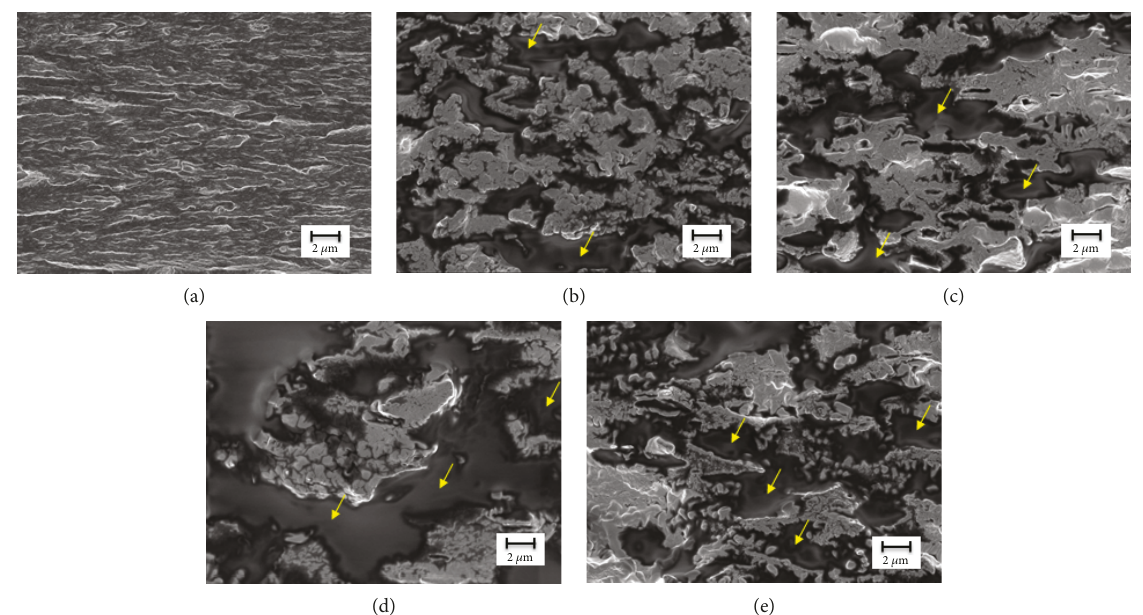
Figure 3: Scanning electron microscopy (SEM) images of the fracture surface of alginate fi lms incorporating various CEO-NE concentrations viewed at a magni fi cation of 5000x: (a) control, (b) CEO-NE 20%, (c) CEO-NE 25%, (d) CEO-NE 30%, and (e) CEO-NE 40%. Arrows show cavity-like structures in the fi lm matrix. Table 2: Optical properties ( L , a , b , and Δ E ) and moisture content of the control and CEO-NE-alginate fi lms. Di ff erent letters in the same column indicate signi fi cant di ff erences at p < 0 05 by the ANOVA test. ∗ The percentages indicate the amount of nanoemulsion